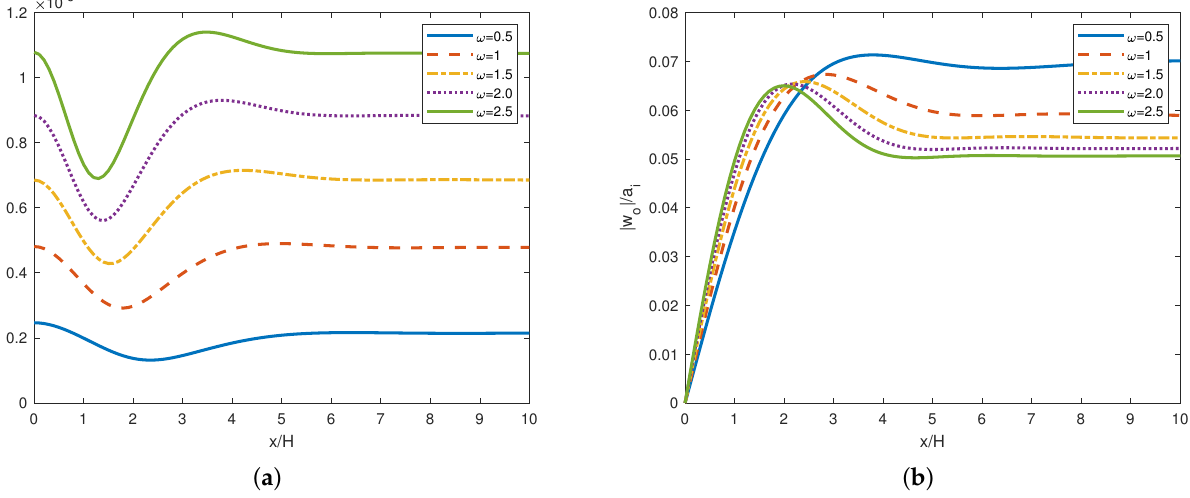
Figure 6. The dimensionless amplitudes of the even ( a ), | w e ( x ) | / a i , and odd ( b ), | w o ( x ) | / a i , compo- nents of the plate deflection for different frequencies of the incident wave ω and ˜ L = 0.5. ( a ) Heave motion case. ( b ) Pitch motion